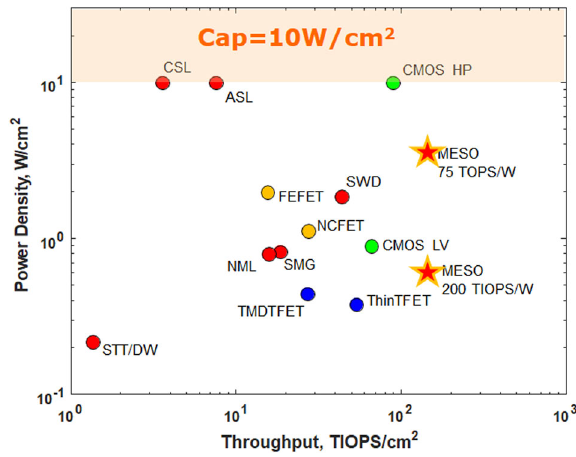
Fig. 4 Dissipated power density vs. computing throughput (in tera- integer-operations per second). The device labels are as in Fig. 3. The power density is capped at 10 W/cm 2 . If the estimated power density exceeds it, the passive area is inserted, and throughput is reduced. Adapted from ref. 74 by permission from Springer Nature,